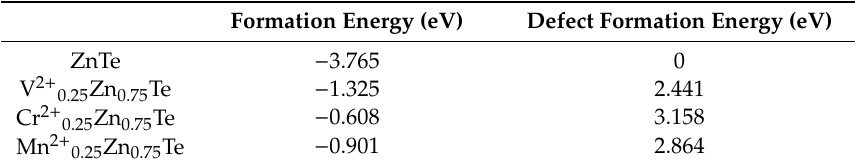
Table 2. Formation and defect formation energies of ZnTe and TM 2 + 0.25 Zn 0.75 Te ( TM = V, Cr,